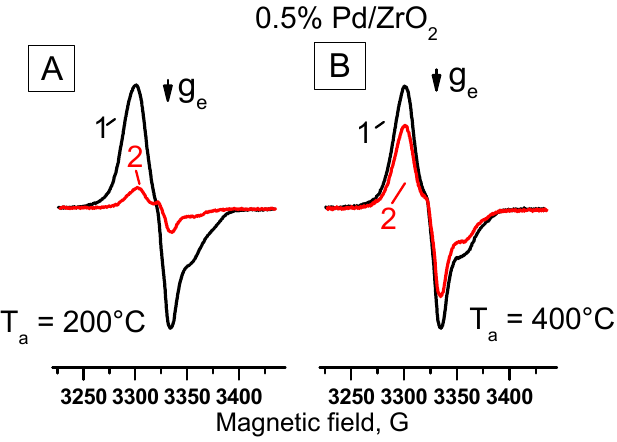
Figure 11. EPR spectra of radical anions resulted from adsorption of TNB on 0.5%Pd/ZrO 2 catalyst before (1) and after three catalytic cycles (2). Prior to carrying out the experiments with spin probes, samples were heated in air at a temperature of: 200 °C ( A ); 400 °C ( B ).